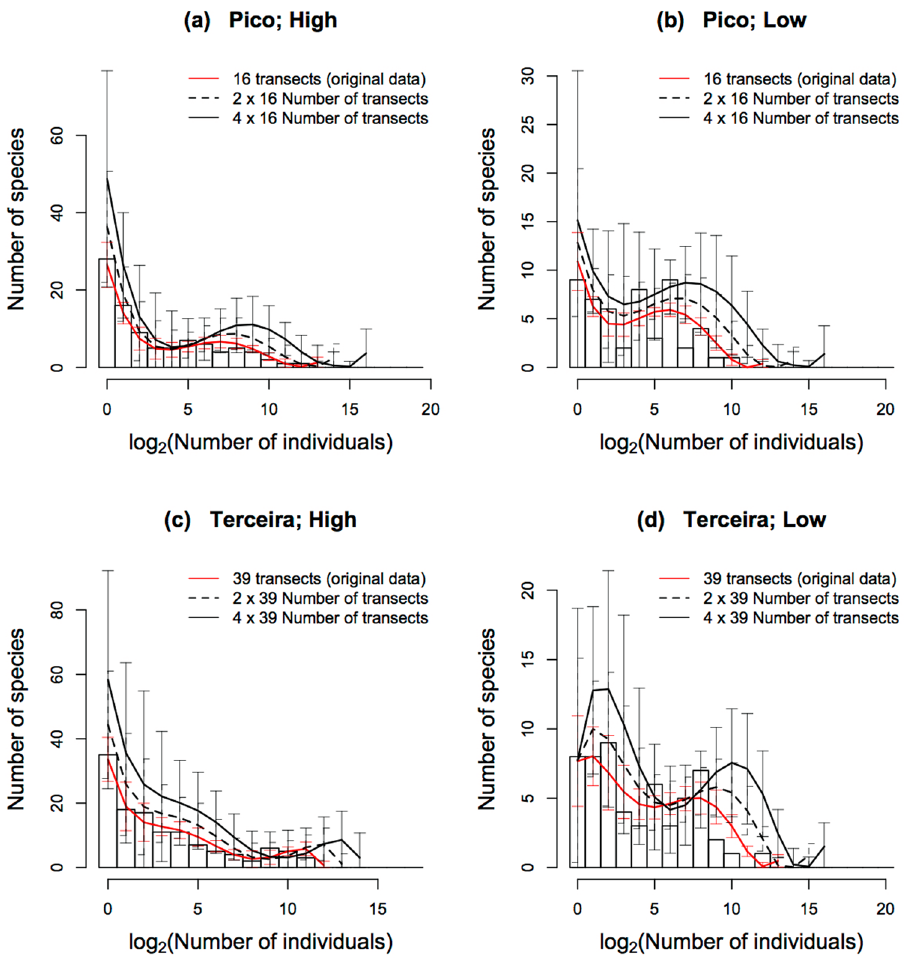
Figure 6. Histograms and extrapolated distributions for arthropod SADs of all transects combined for the Pico and Terceira islands. The red curve is the distribution estimated from all transects using the scaled Tchebichef moments and polynomials. The black and full dashed lines are the forecasted distributions for two and four times the original number of transects and they correspond to the mean value of the distributions obtained for all possible additions of transect sequences; these distributions were used to obtain ± 2 standard deviations shown by the error bars. We used up to the 4 th order moment for both the high and low dispersal ability species of Pico Island and to 3 rd and 5 th order moments for the high and low dispersal ability species, respectively, of Terceira Island. The x-axis corresponds to classes of the logarithm of the number of individuals as follows: 1 individual, 2 to 3 individuals, 4 to 7 individuals, et seq